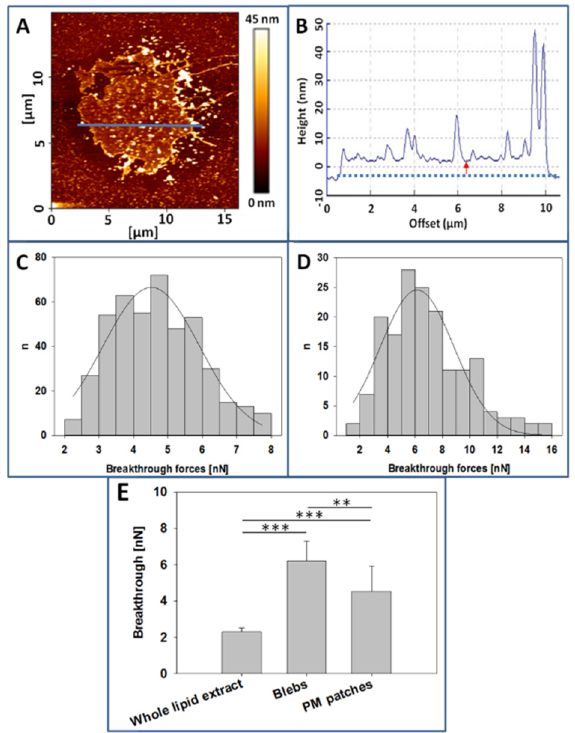
Figure 5. Atomic Force Microscopy (AFM) measurements. ( A ), CHO cell plasma membrane patch over polylysine-coated mica. ( B ), Topographic image of the cross-section indicated by the blue line in 5A. ( C ), Breakthrough forces distribution of CHO cell plasma membranes (PM) patches. ( D ). Breakthrough forces distribution of CHO cell blebs. ( E ). Comparison of breakthrough forces, data extracted from experiments as in C, D. Whole lipid extract breakthrough value was obtained from supported planar bilayers formed with CHO cell lipid extracts. ( n = at least 160, value = mean + SD) Statistically significant differences were calculated with ANOVA and Student´s t-test. Significance: (**) p < 0.01; (***) p < 0.001.